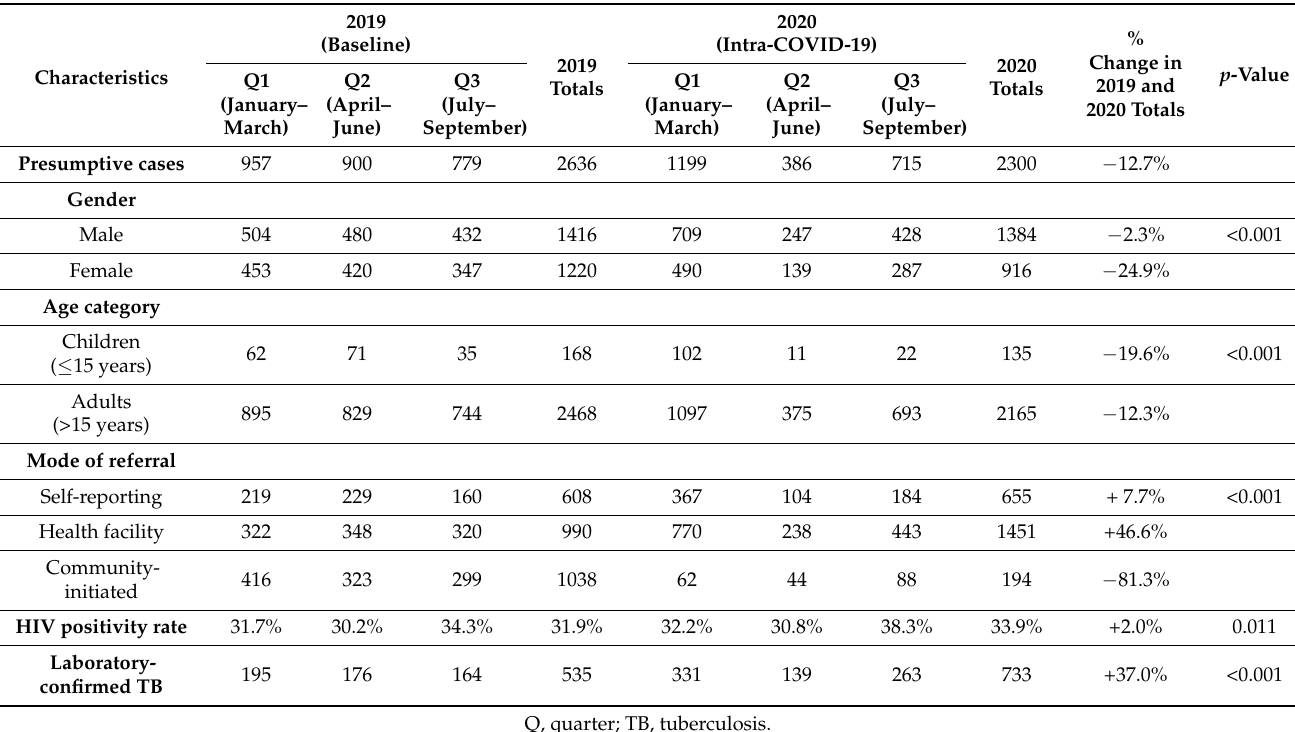
Table 1. Comparison of referrals for TB testing and laboratory confirmed TB cases during the pre- and intra- COVID-19 periods.